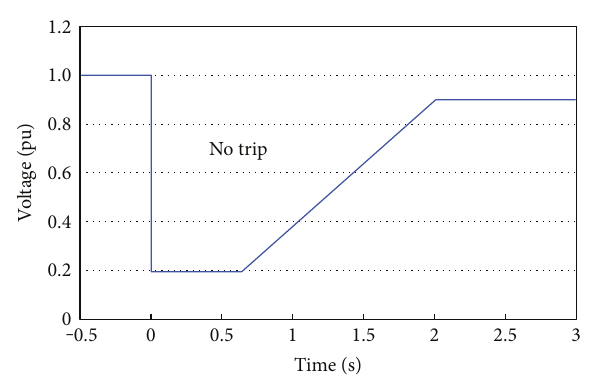
Figure 14: LVRT requirement.